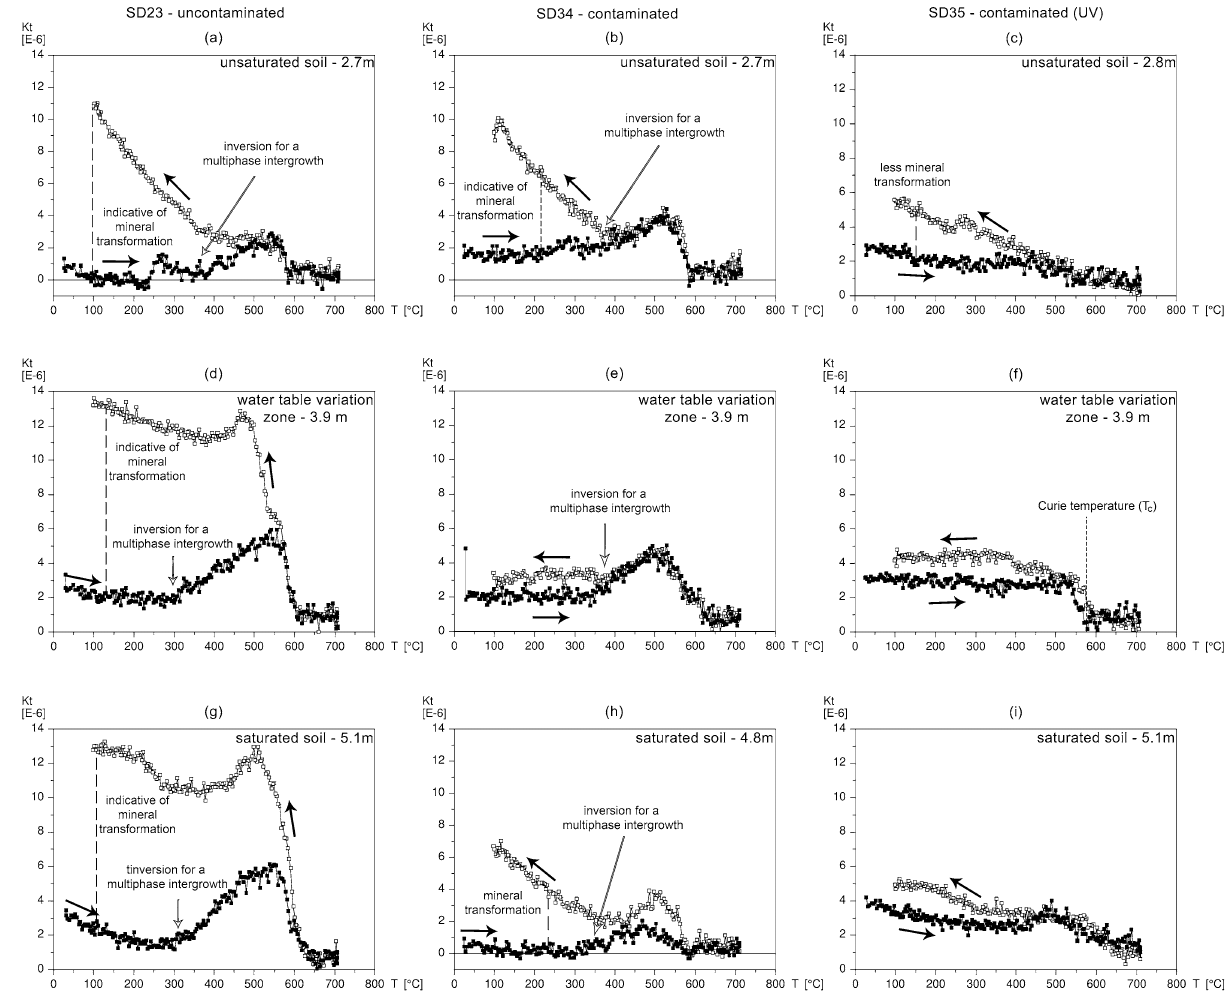
Figure 3. Thermomagnetic curves of uncontaminated and contaminated cores: MS changes during heating (full squares) and cooling (empty squares). ( a – c ) Samples from the unsaturated zone below the landfill; ( d – f ) Samples from the water table fluctuations zone and ( g – i ) Samples from the saturated zone. Arrows indicate the heating and cooling